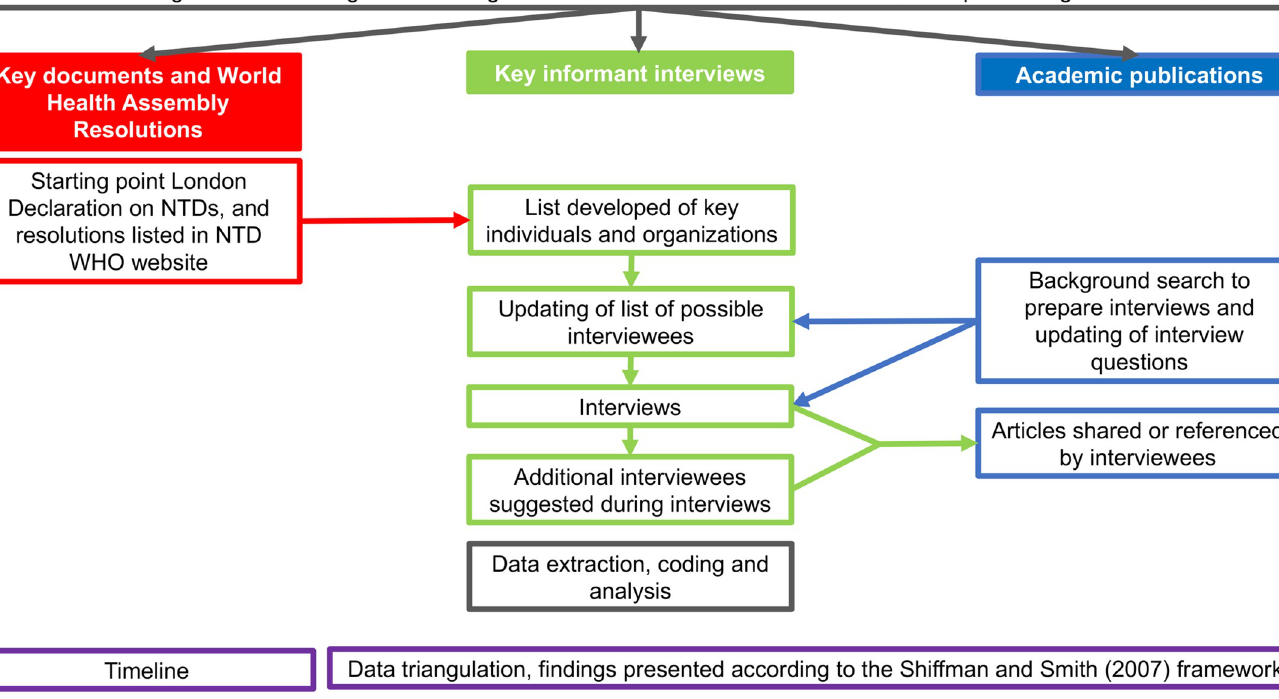
Fig 1. Methodological